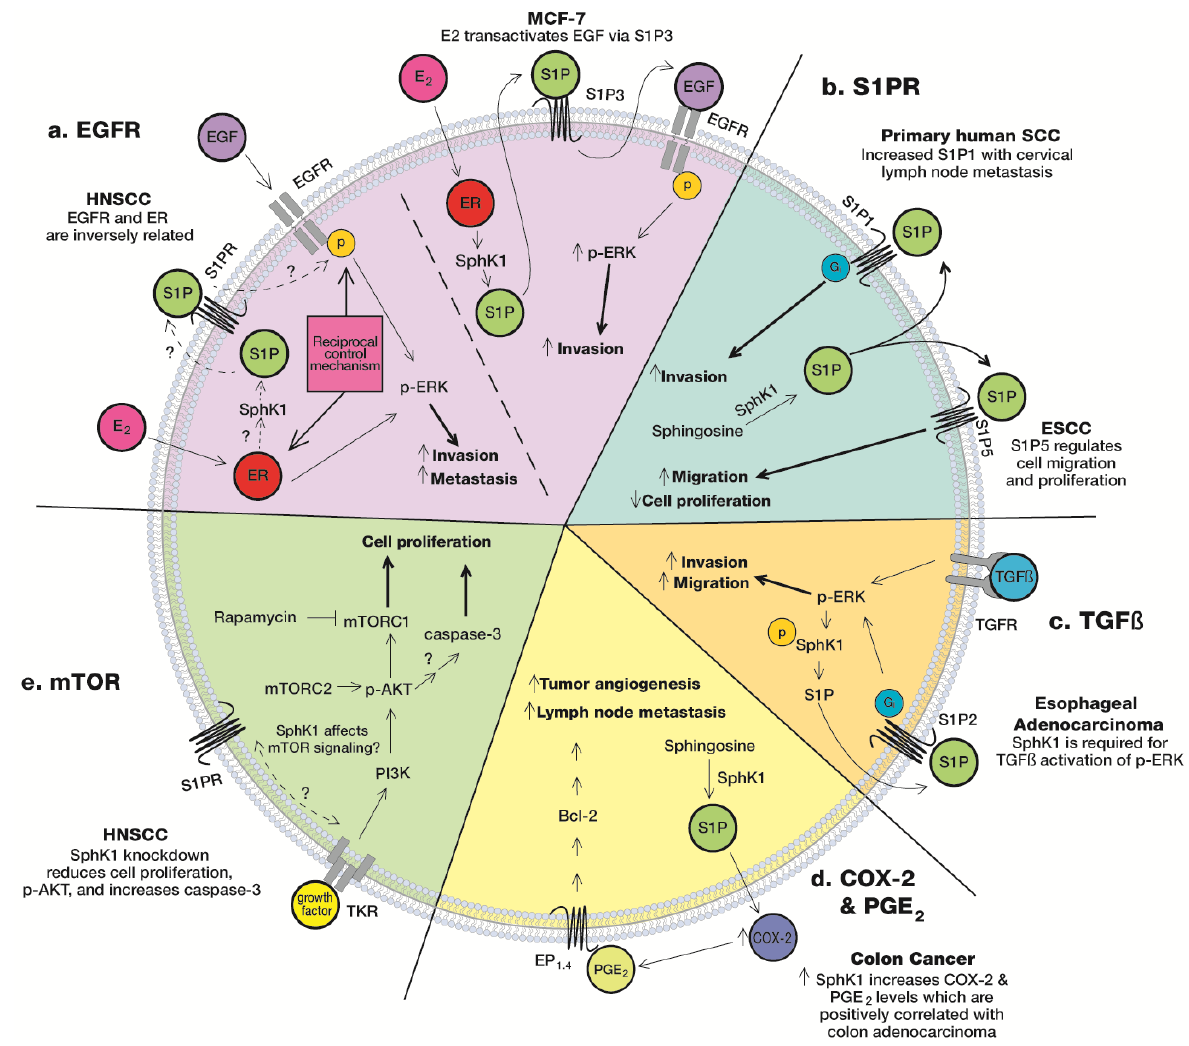
Figure 1. Suggested roles of SphK1 in HNSCC. EP: E-prostanoid receptor; TKR: tyrosine kinase